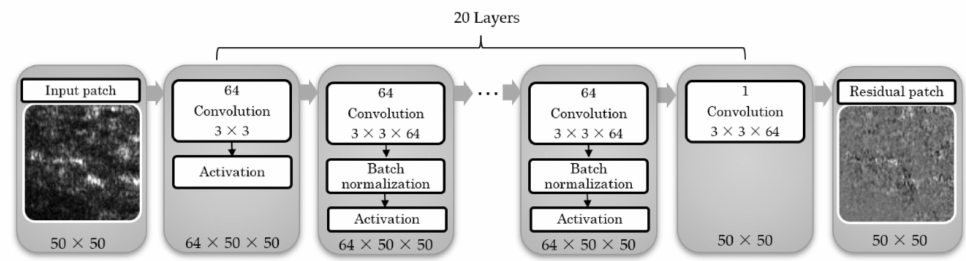
Figure 2. The deep learning architecture of the denoising convolutional neural network